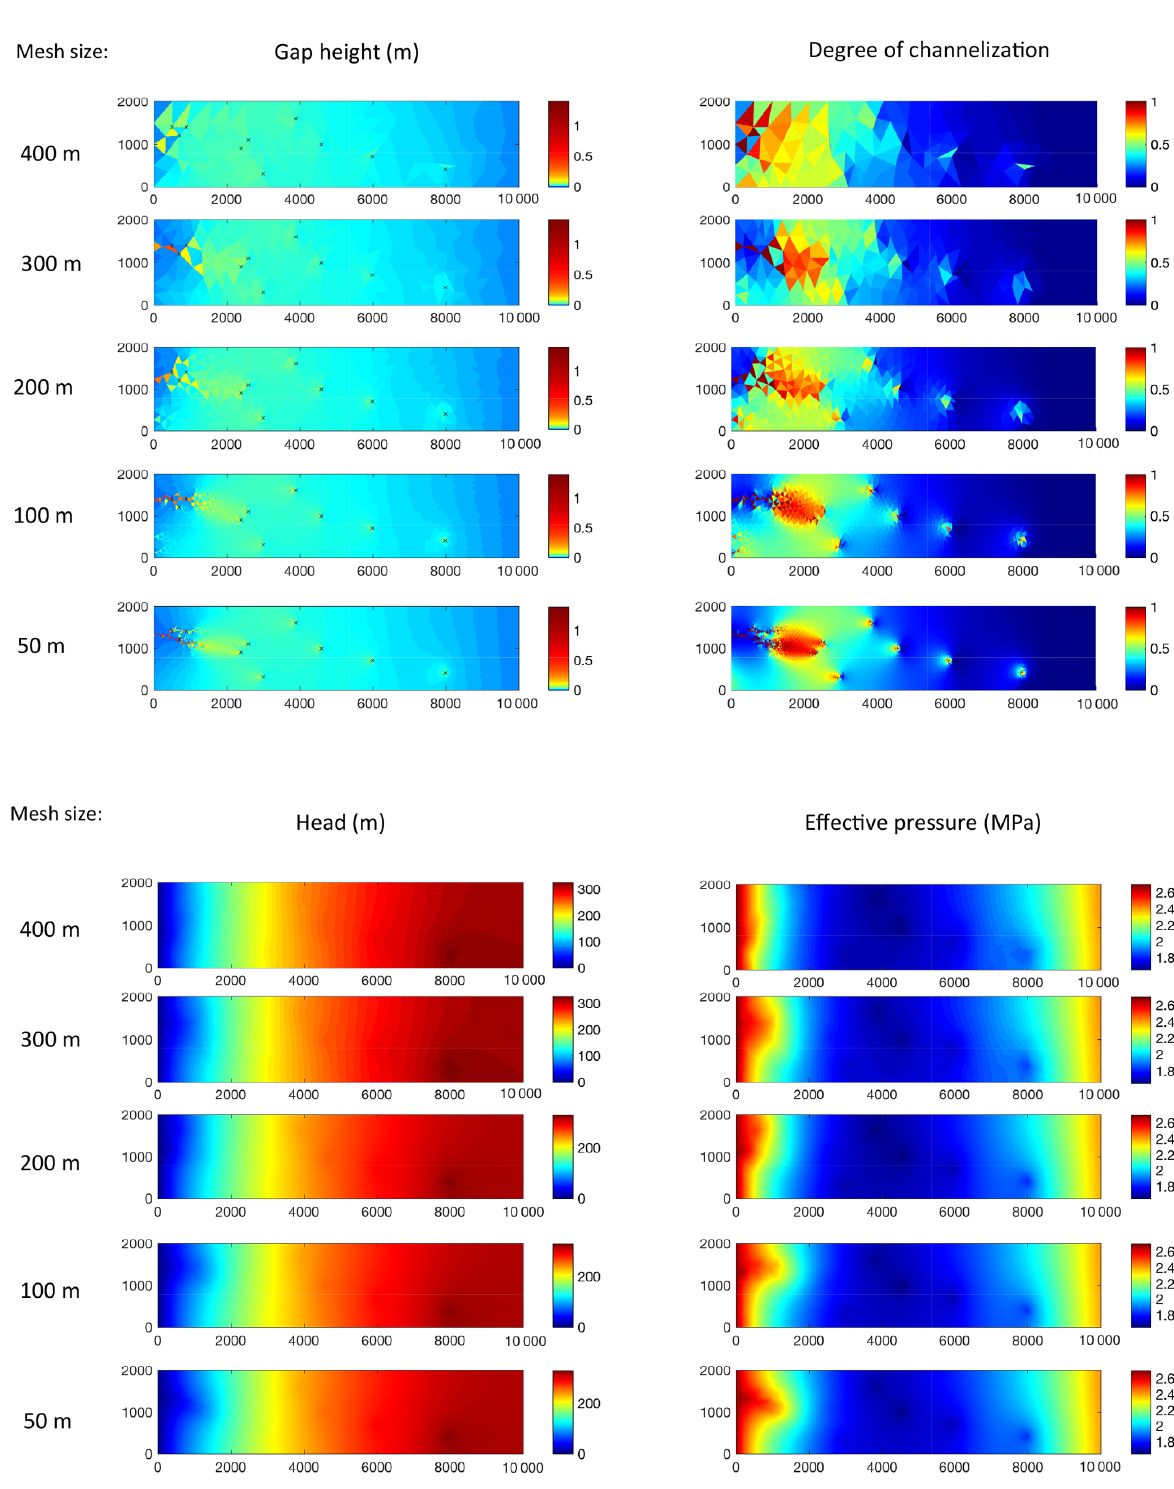
Figure 3. Steady-state distributions resulting from steady input of 10m 3 s − 1 into 10 moulins. As a qualitative evaluation of mesh dependence, results are shown for typical element side lengths ranging from 50 to 400m. Moulin locations are indicated on the gap height plots as black markers. Rather than each moulin forming an independent channel, the various inputs warp the pressure field and interact to produce a principal efficient drainage